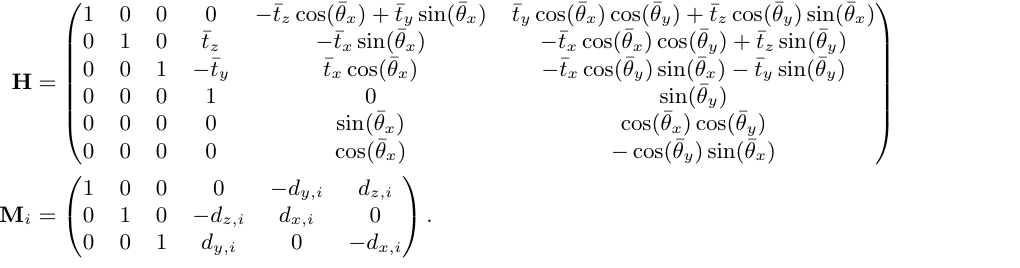
Figure 2. Definition of the matrix decomposition M and H